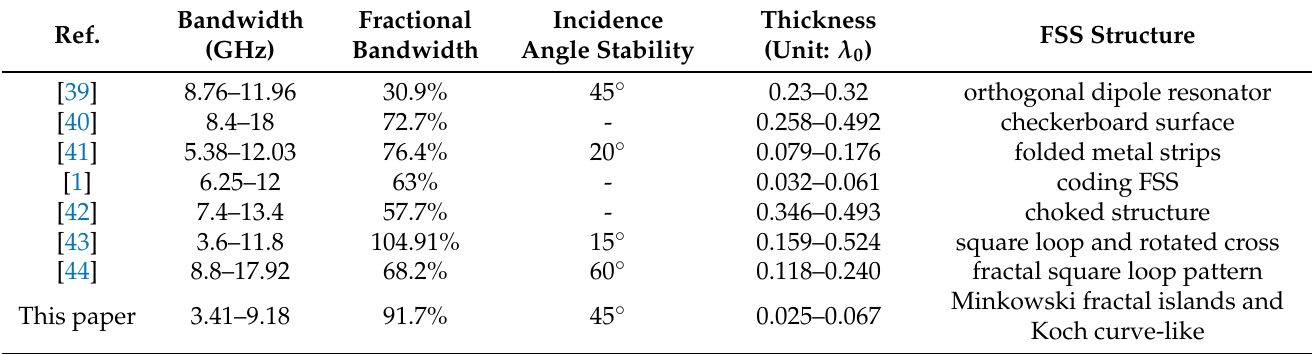
Figure 11. The measured and simulated transmission coefficient of the fractal FSS optimized by IBFO as a function of the oblique incidence angles with ( a ) TE polarization and ( b ) TM polarization. Based on the size and broadband performance of the FSS proposed in this paper, it is compared to the FSS proposed in previous studies [39–44]. The performance comparison is shown in Table 5. The FSS proposed in ref. [43] has a larger fractional bandwidth than the FSS proposed in this paper, but its oblique incidence angle stability is 15 ◦ . Compared with the same type of fractal structure FSS [44], taking into account the fractional bandwidth and oblique incidence angle stability jointly, the proposed FSS achieves better performance. In addition, the proposed FSS has a very thin thickness with 0.025 λ and 0.067 λ at the lowest and highest frequencies, respectively. Table 5. Performance comparison between the proposed fractal FSS and the previously reported broadband